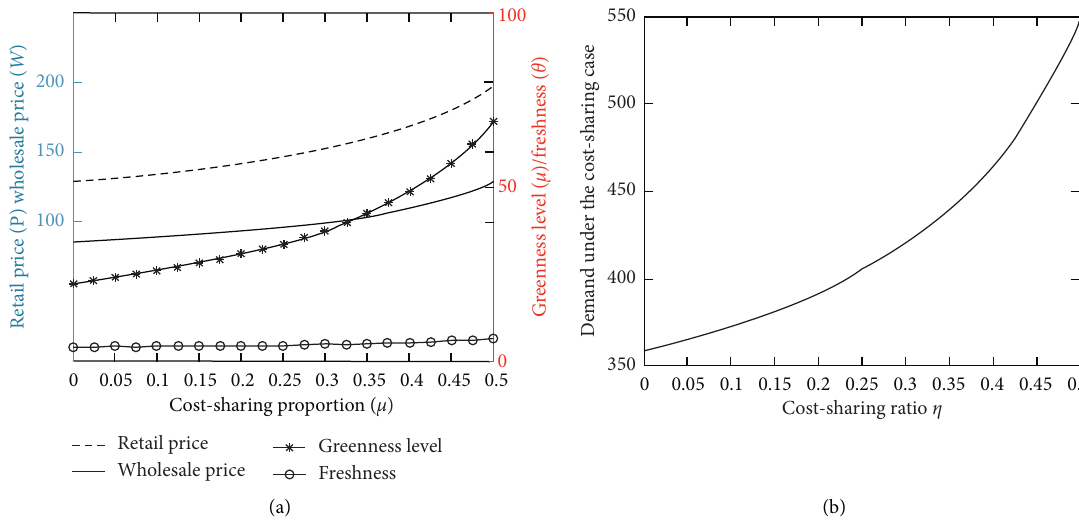
Figure 5: The impact of the cost-sharing proportion ( η ) on the variables: (a) cost-sharing proportion ( η ) ; (b) cost-sharing